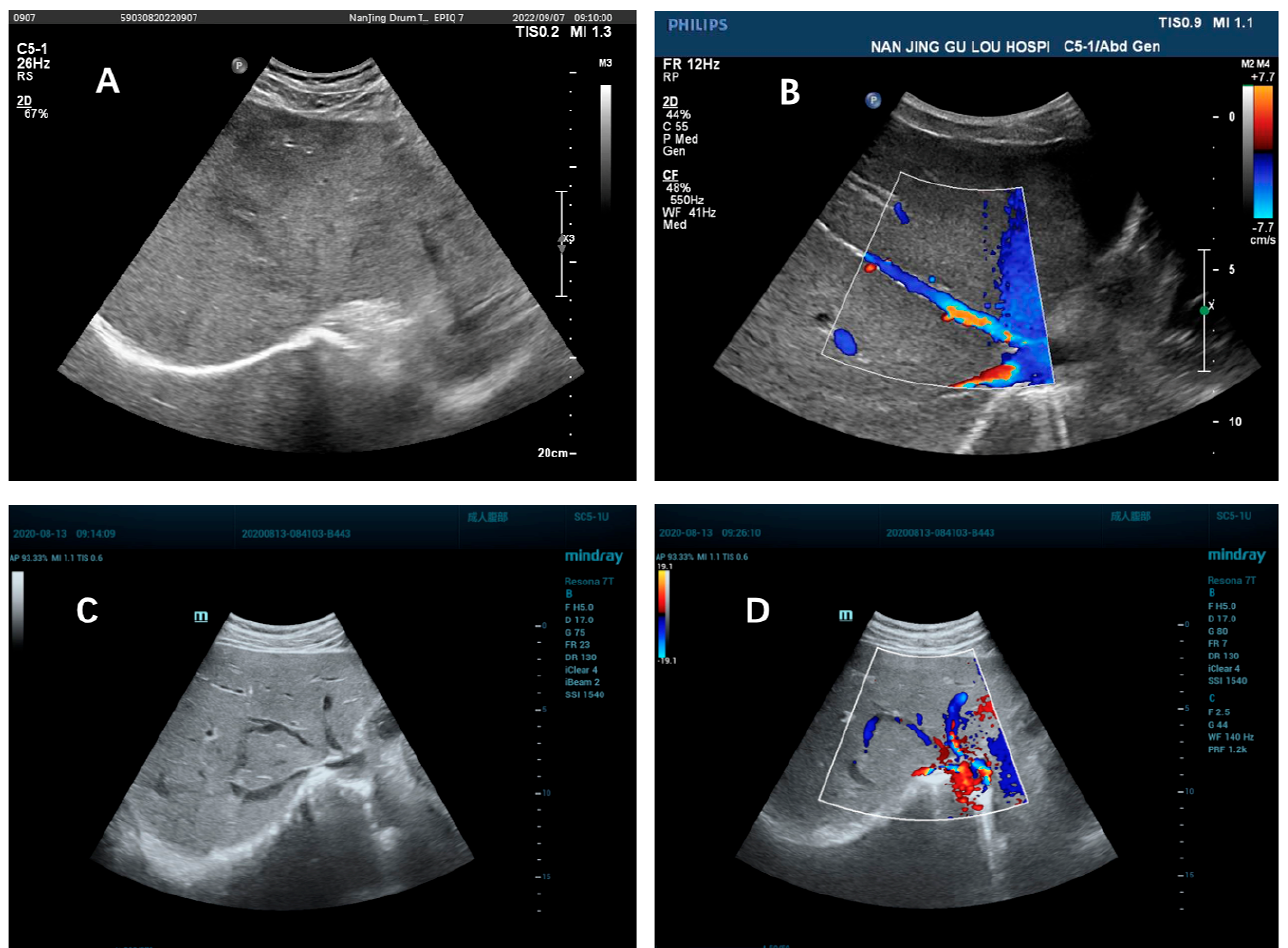
Figure 3. Ultrasound images of BCS-HV and PA-HSOS patients. ( A ) Uneven attenuation of the liver in a patient with PA-HSOS; ( B ) Unobstructed hepatic veins of the PA-HSOS patient; ( C ) Middle hepatic vein occlusion in BCS-HV patients; ( D ) Ultrasound images showed that the middle hepatic vein was occluded and collateral circulation of hepatic